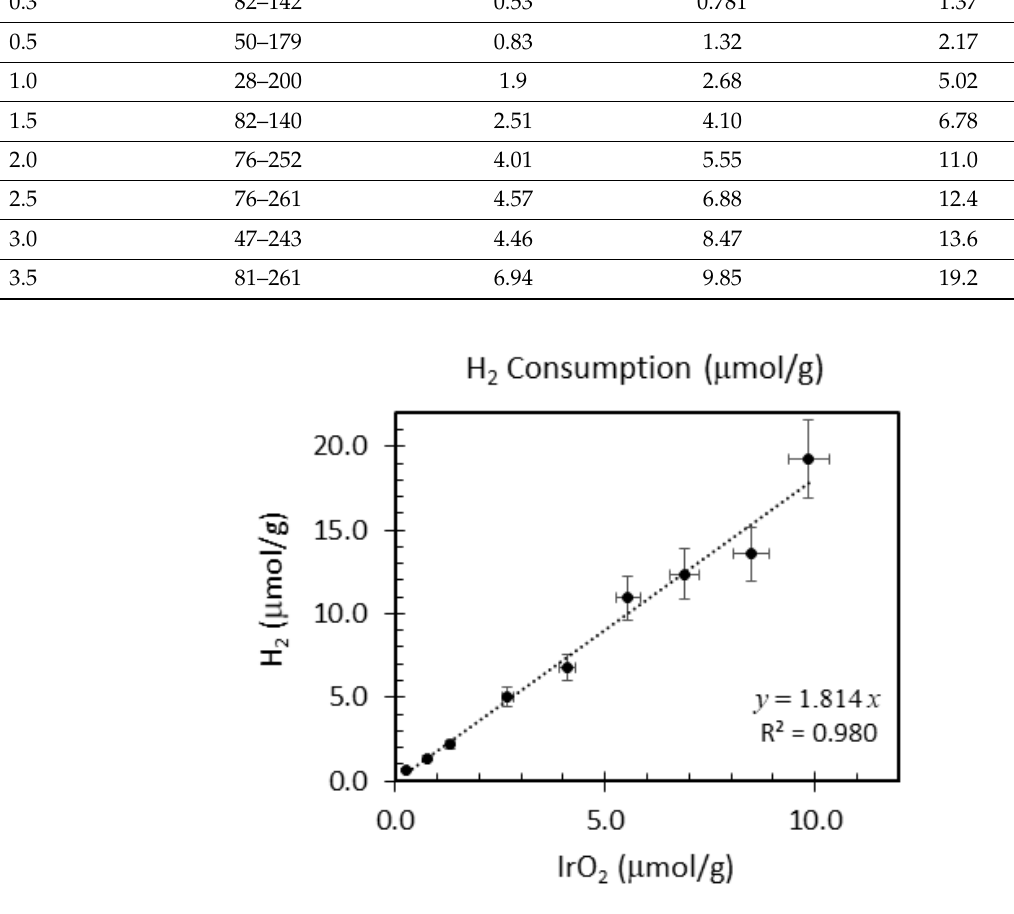
Figure 1. Normalized molecular hydrogen consumption per g of catalyst as a function of IrO 2 content for the IrO 2 /TiO 2 (anatase, BET surface area = 55 m 2 /g) series; between 0.1 and 3.5 wt.% (the wt.% of IrO 2 is converted to micromoles per g of catalyst in the x -axis). The slope of the linear regression of 1.81 is close to the theoretically expected one (2H 2 + IrO 2 → 2H 2 O + Ir). Error bars are